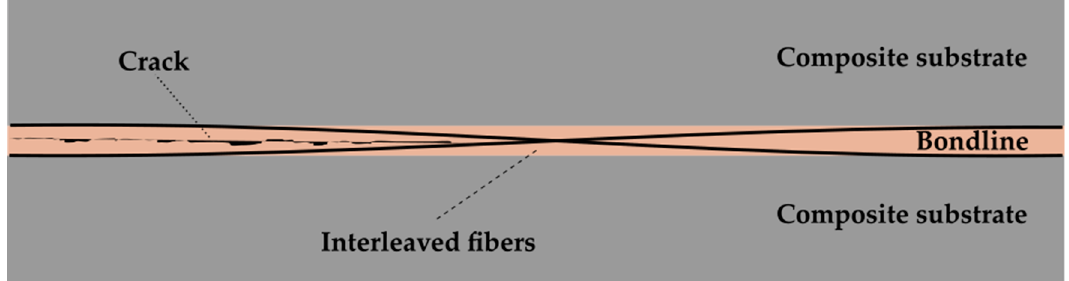
Figure 4. The interleaved fibers’ concept as a crack arrester.